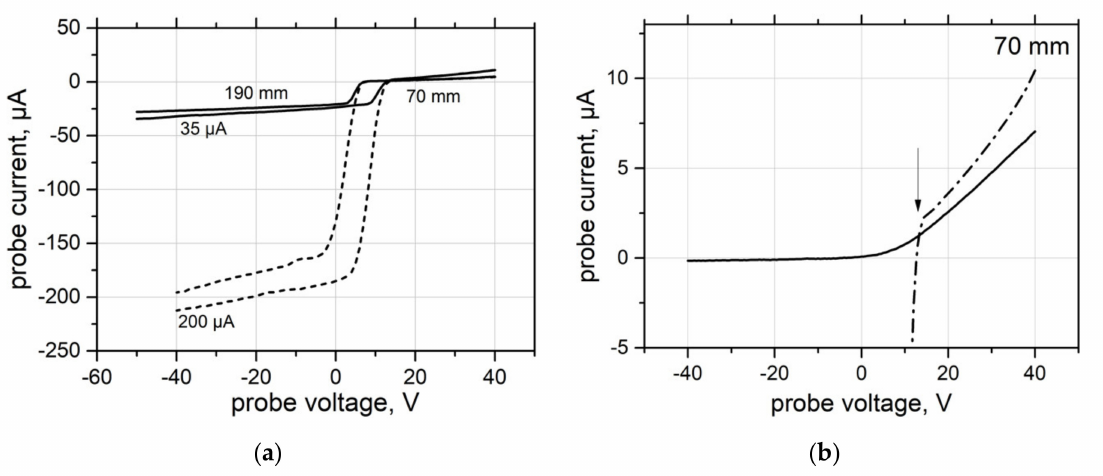
Figure 7. ( a ) Example of the emissive probe voltage current characteristics at two heating powers. The curves taken at two distances and two heating currents are shown for hot probe. ( b ) The comparison of the hot and cold regimes of the probe. The VCC of the cold probe (solid line) is compared to that of the hot probe (broken line). Distances from the engine cut-off are given. Arrow indicates the plasma